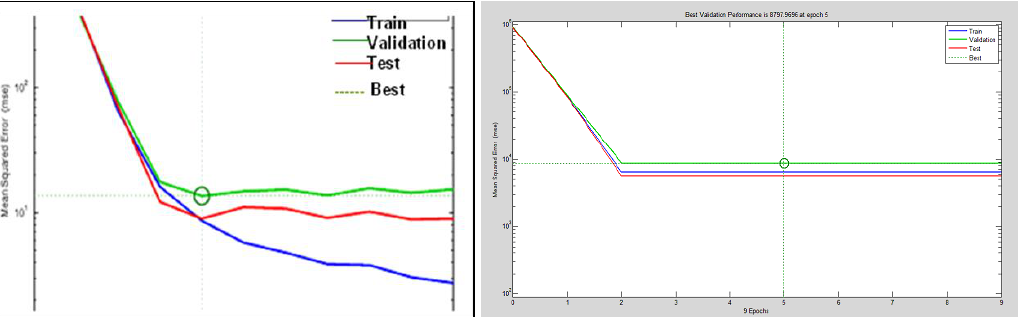
Fig. 3. Training of the ANN model